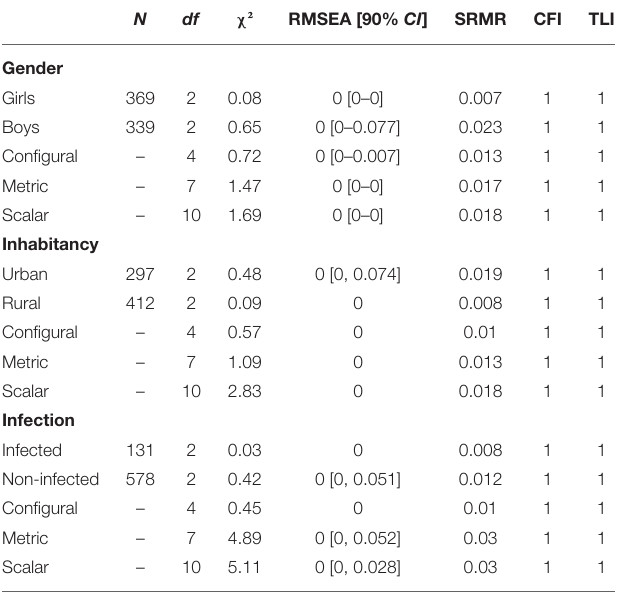
TABLE 3 | Measurement invariance of the OCS across gender, inhabitancy, and infection groups. N df χ ² RMSEA [90% CI ] SRMR CFI TLI